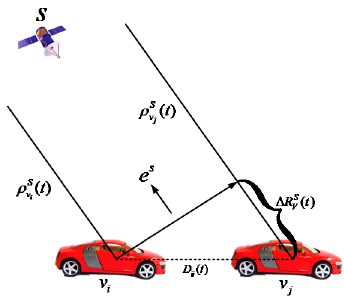
Figure 5. Single differencing distance.